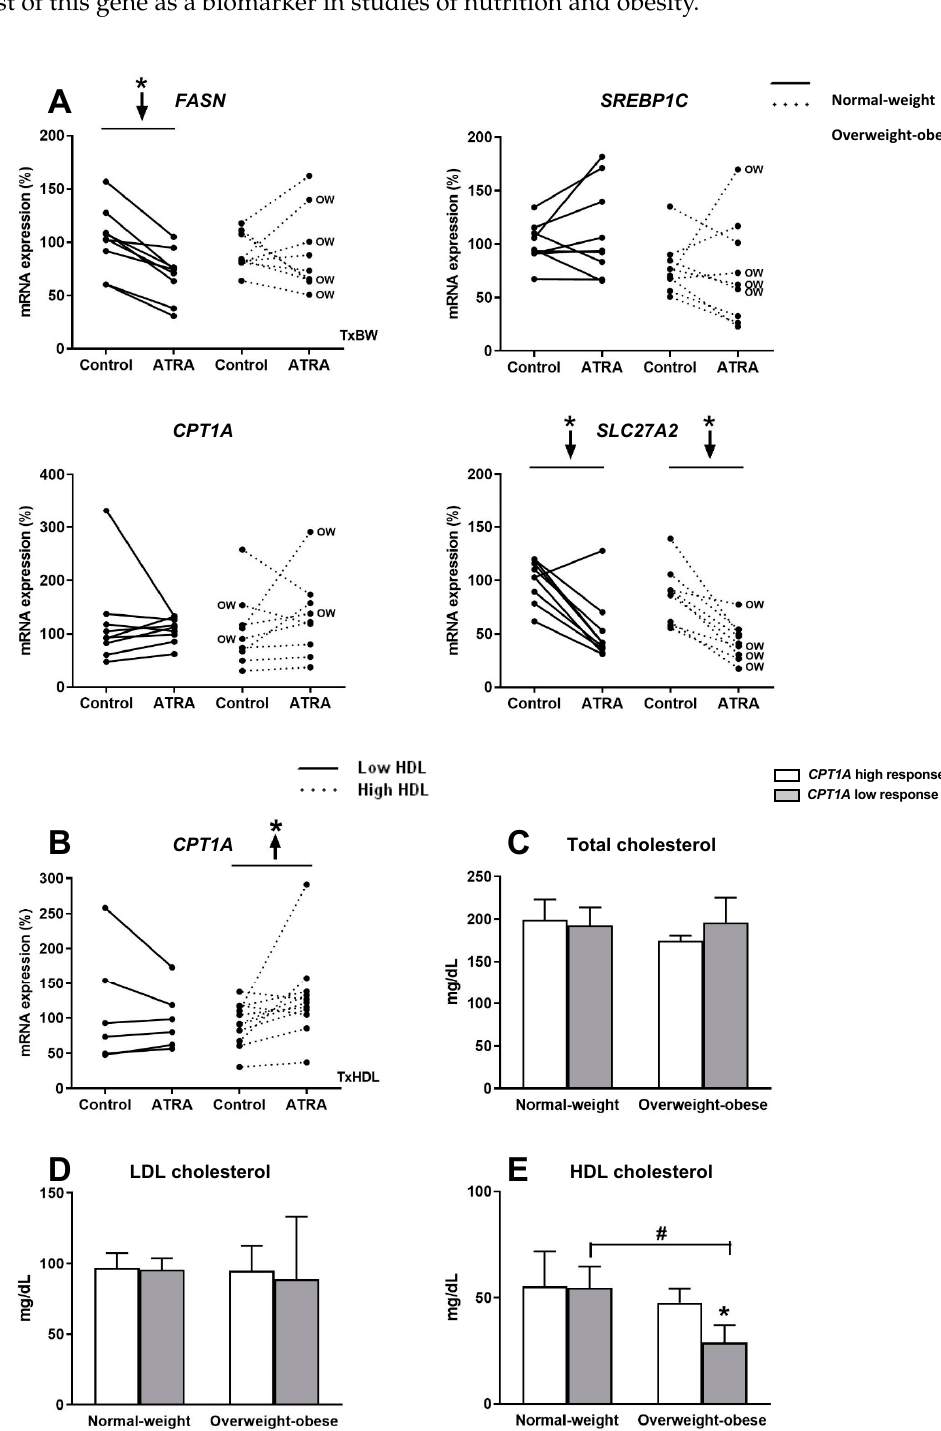
Figure 5. ( A ) E ff ect of ATRA treatment on mRNA expression of key fatty acid synthesis genes ( FASN and SREBP1C ), the key fatty acid oxidation gene ( CPT1A ), and a fatty acid transport gene ( SLC27A2